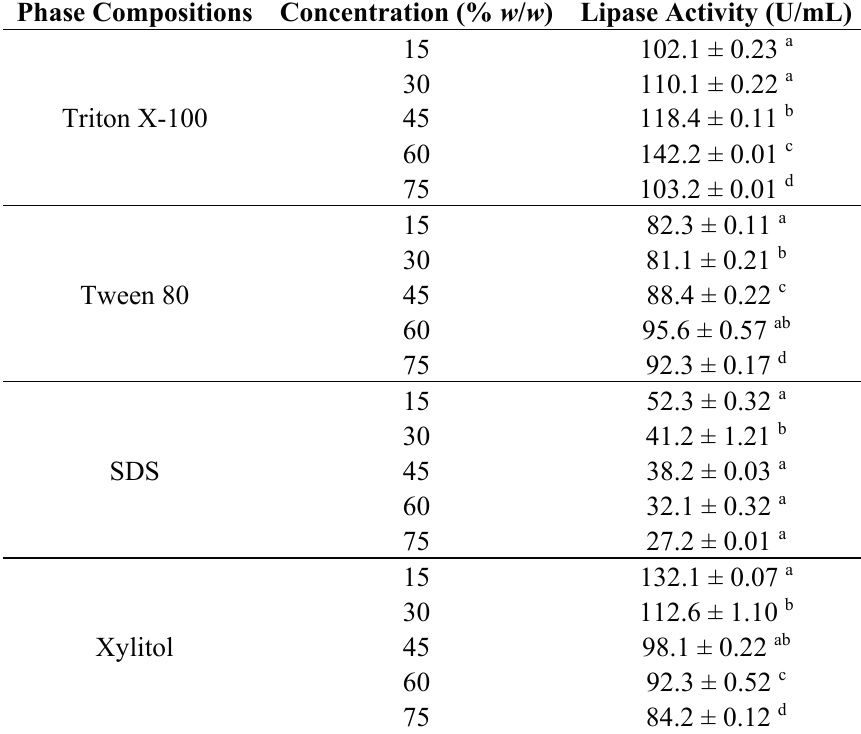
Table 1. Effects of various phase compositions on the lipase activity of Cucurbita moschata Phase composition.